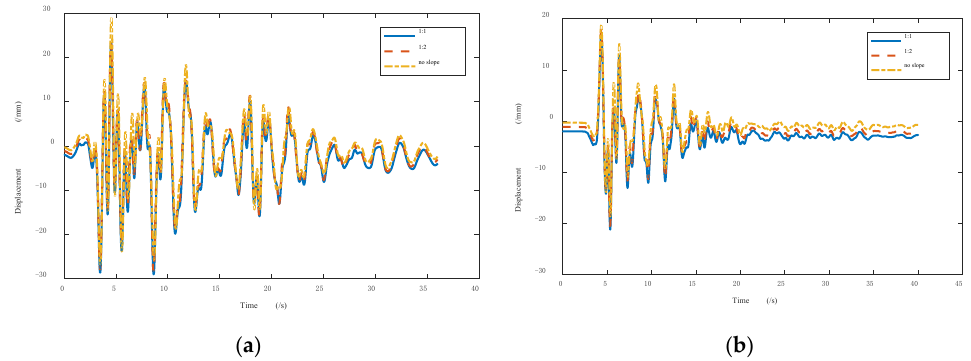
Figure 9. Time history curve of horizontal displacement of the top layer: ( a ) working condition 6; ( b ) working condition 18.